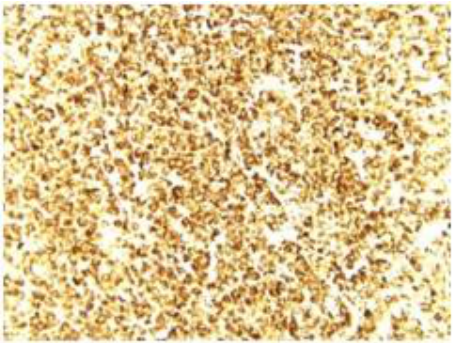
Figure 3. Immunohistochemical stain (PGP 9.5, ob 40×) showing intense cytoplasmic positive reaction of PGP 9.5 in all tumor cells.